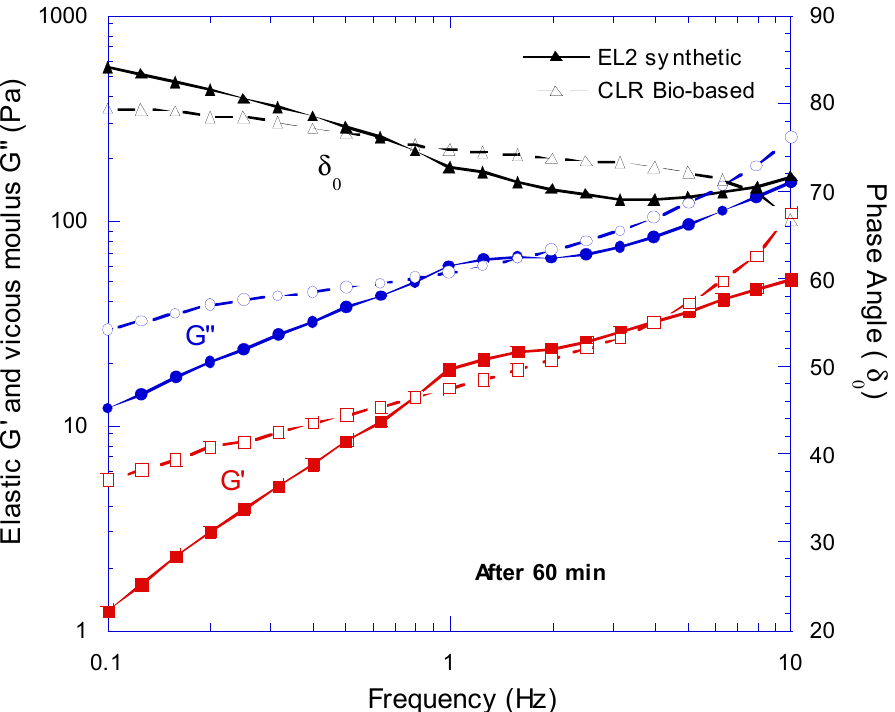
Figure 11. Comparison of frequency sweep test results of CLR bio-based (dash lines) and EL2 synthetic epoxies (solid lines) after 60 min of hardener mixing.